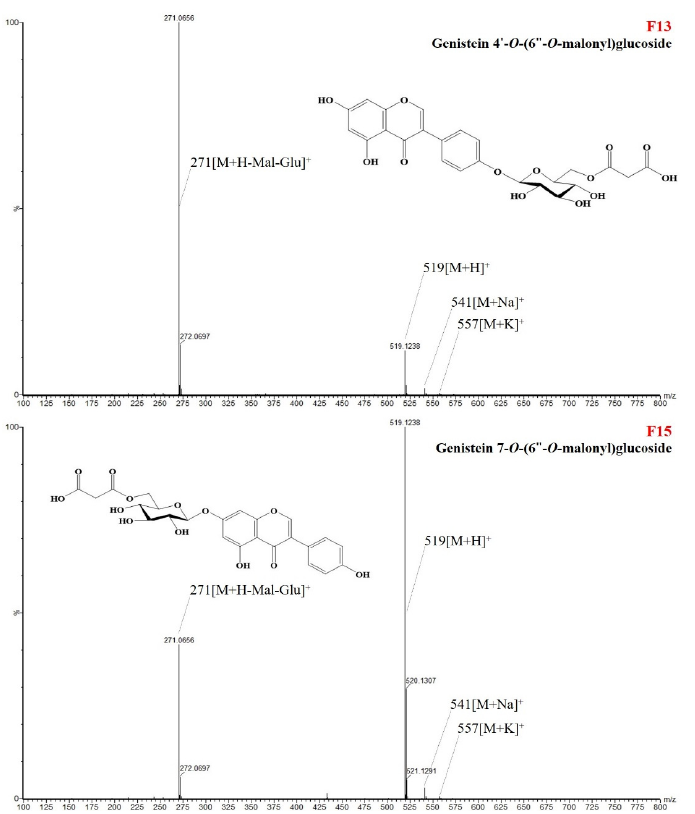
Figure 4. Structures and ESI (+)-QToF/MS fragmentations ( m / z , 519 [M + H] + ) of two representative isoflavone derivatives (F13 and F15) in soybean ( Glycine max L.)